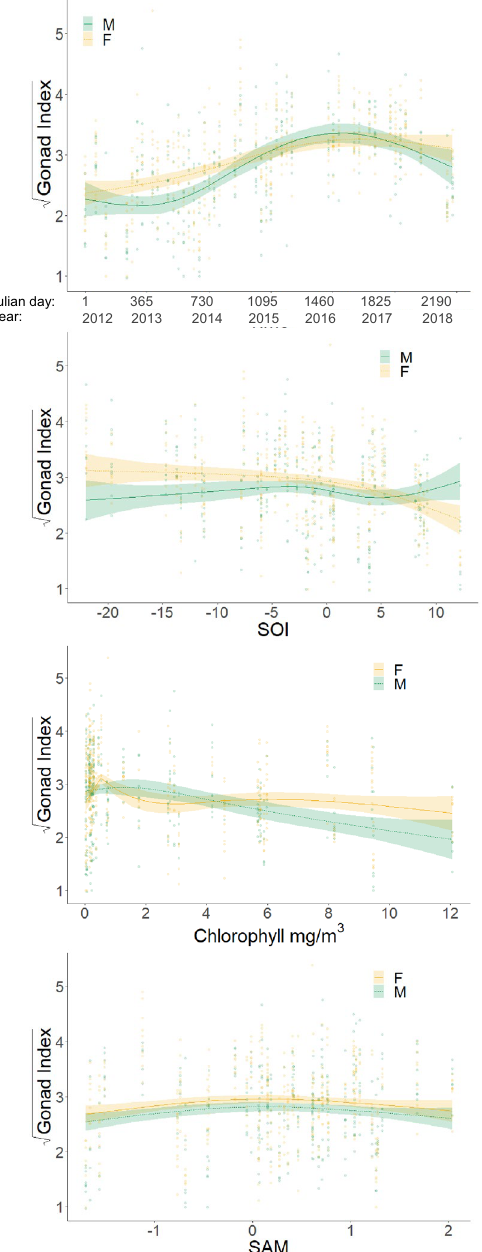
Figure 4. Smoothers of the effect of the three non-parametric terms: time, Southern Oscillation Index (SOI), chlorophyll and Southern Annular Mode (SAM), on the gonad index of Sterechinus neumayeri, from the optimal GAM model. Shaded area represents a 95% confidence interval and data points represent raw gonad index data. The magnitude of change in gonad index as a response to the change in the x-variable is represented on the y-axis as the square-root transformed gonad index. For the axis ‘time’, year intervals are plotted on every 1st January. Green represents males and yellow represents